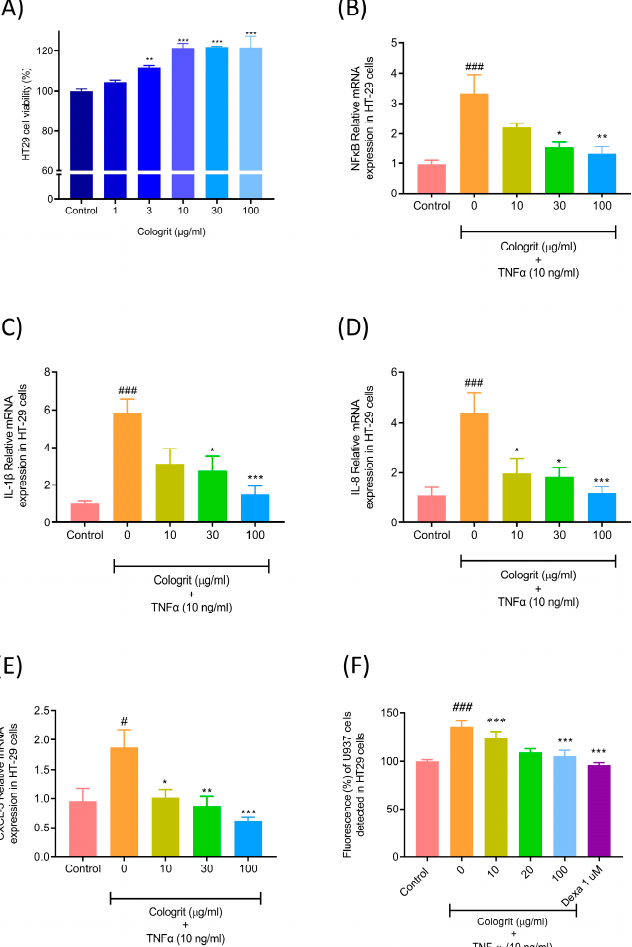
Figure 3. Biocompatibility and anti-inflammatory potential of Cologrit formulation in HT-29 cells . ( A ) Cell viability analysis was used to determine the dose response of the Cologrit formulation in